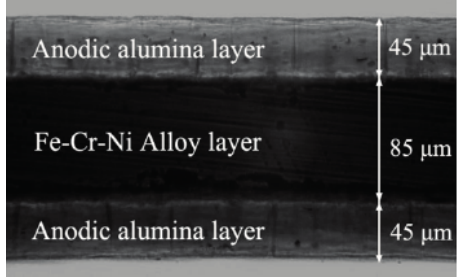
Figure 23. Anodic alumina support cross-sectional image